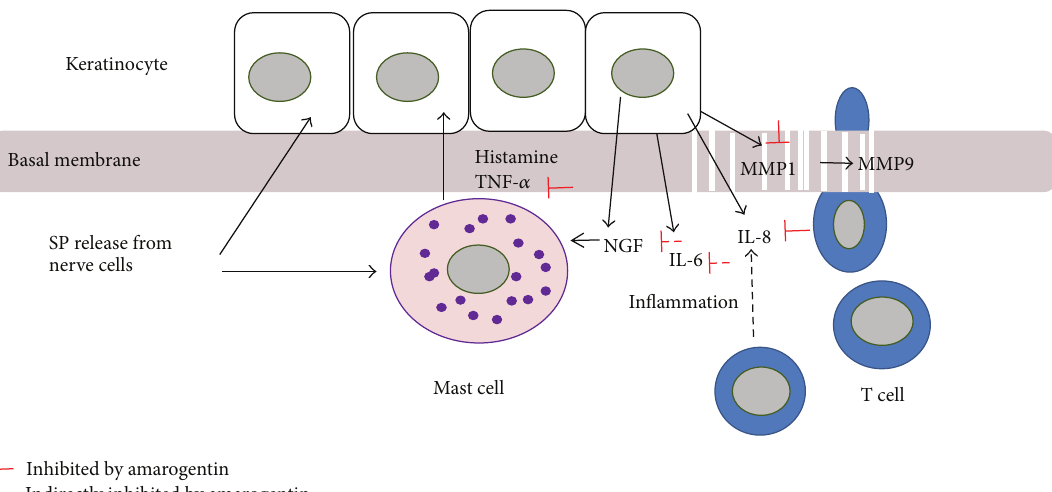
Figure 6: Simplified working hypothesis for the reaction mechanism of TAS2R agonists on cellular interactions among mast cells, T cells, and keratinocytes in the epidermis and uppermost dermis of inflamed skin. The reaction might be triggered by substance P (SP) released from nerve cells. The TAS2R agonist amarogentin inhibits the secretion of TNF- 𝛼 from mast cells. Furthermore, the section of MMP-1 and IL-8 is directly inhibited by amarogentin in histamine and TNF- 𝛼 costimulated human keratinocytes. Reduced MMP-1 expression results in reduced degradation of the basement membrane and reduced T cell transmigration to the epidermis. This may reduce the secretion of inflammatory cytokines by T cells in the